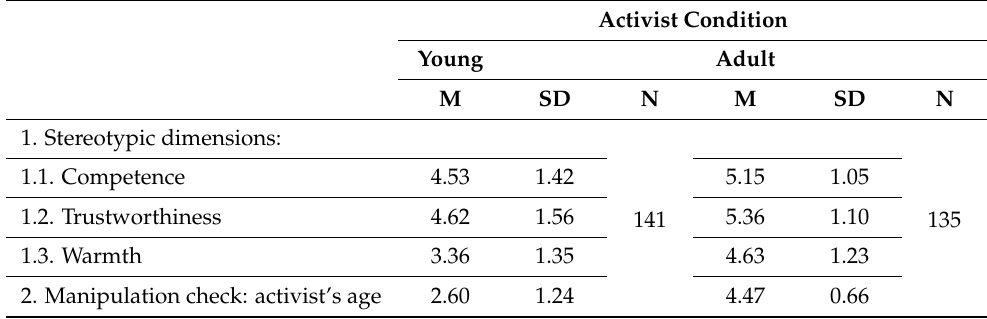
Table 1. Descriptive statistics by experimental condition (means, standard deviations).